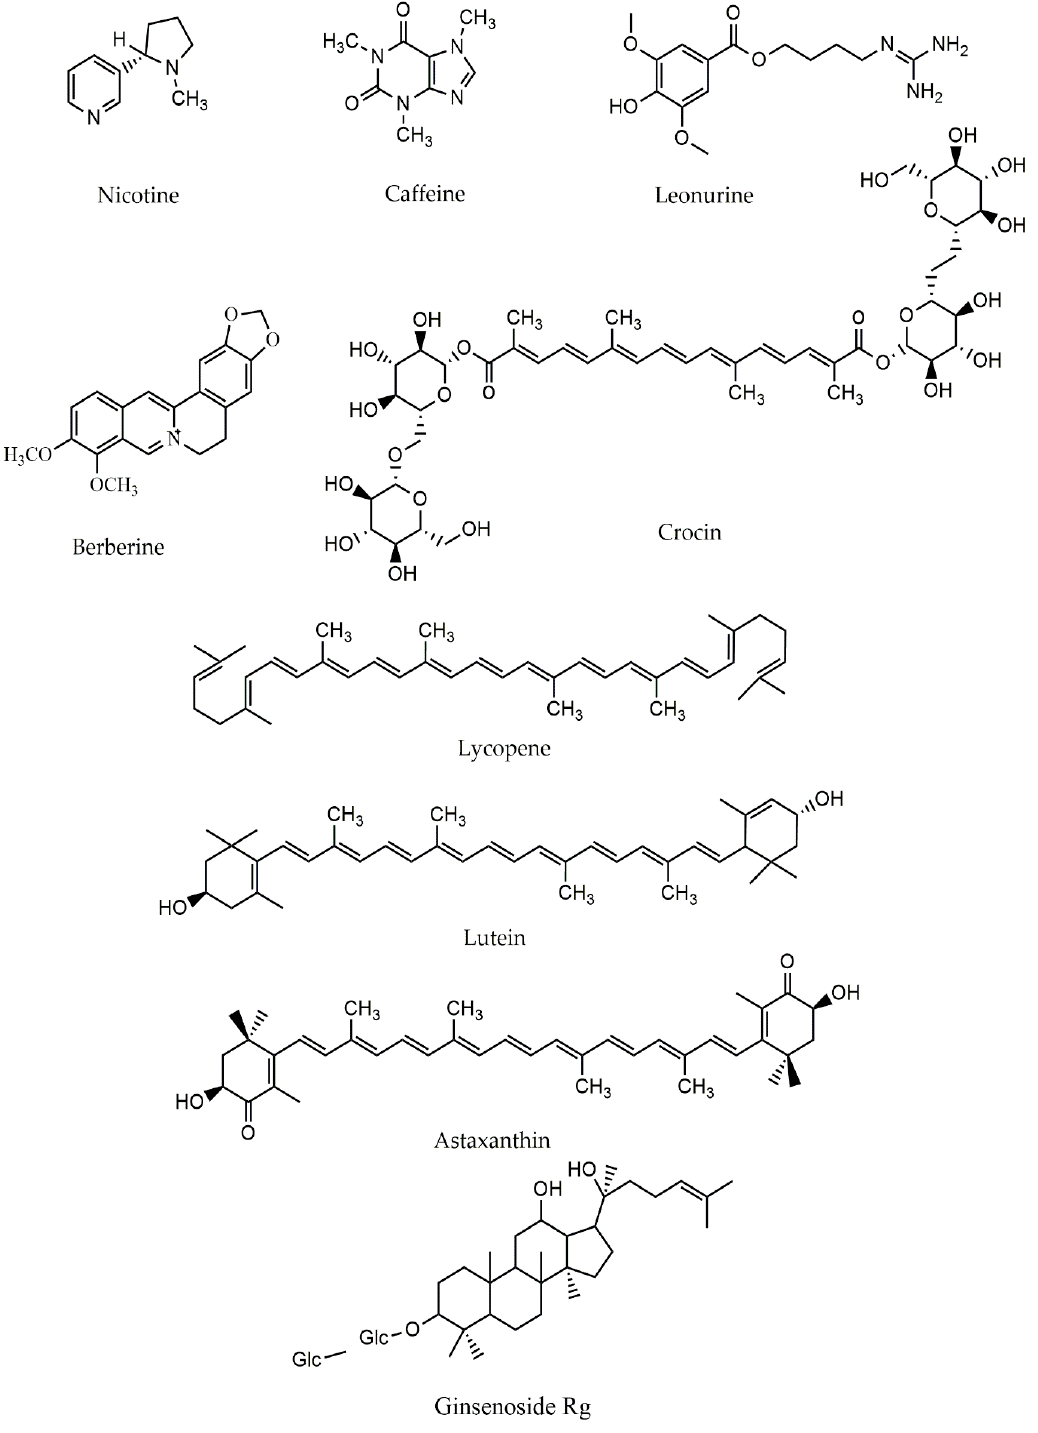
Figure 3. The chemical structure of alkaloids/terpenoids.